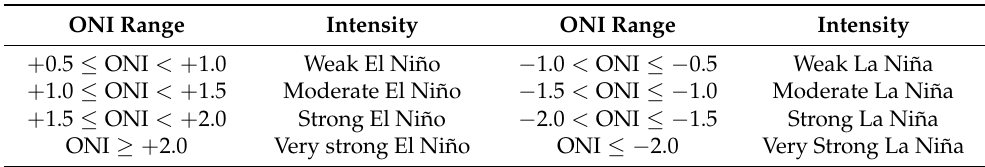
Table 2. Classification of ENSO event intensity using the ONI index (the ONI in the range [–0.5, 0.5] denotes the normal